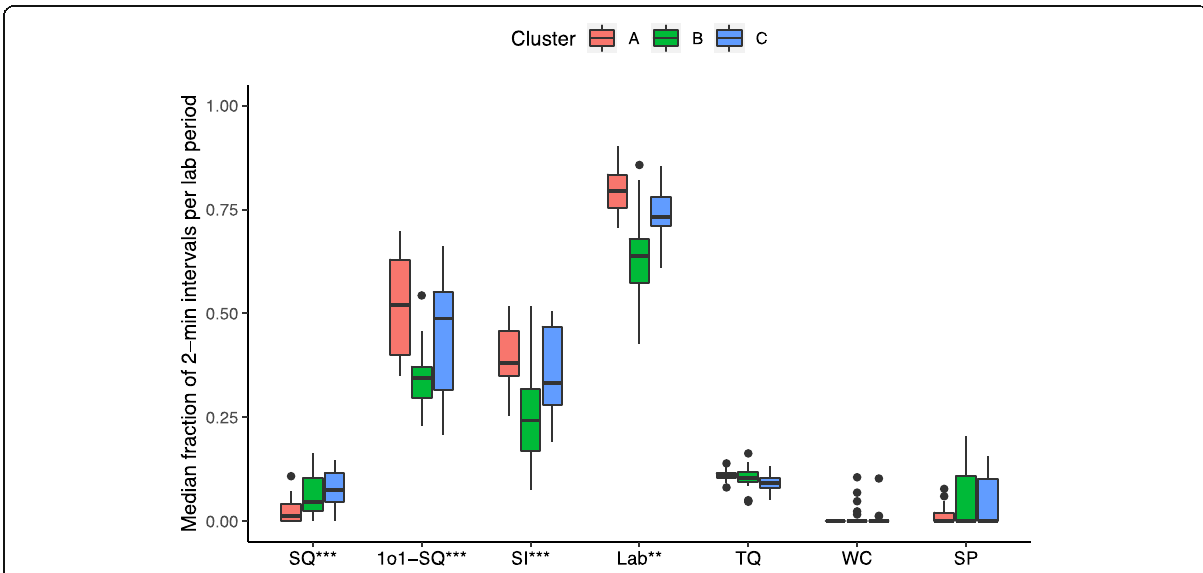
Fig. 3 Median fraction of student codes in each cluster. Four codes are statistically significantly different between clusters, three of which (SQ, 1o1-SQ, SI) have large effect sizes and one has medium effect size (Lab). ***Large effect sizes. **Medium effect